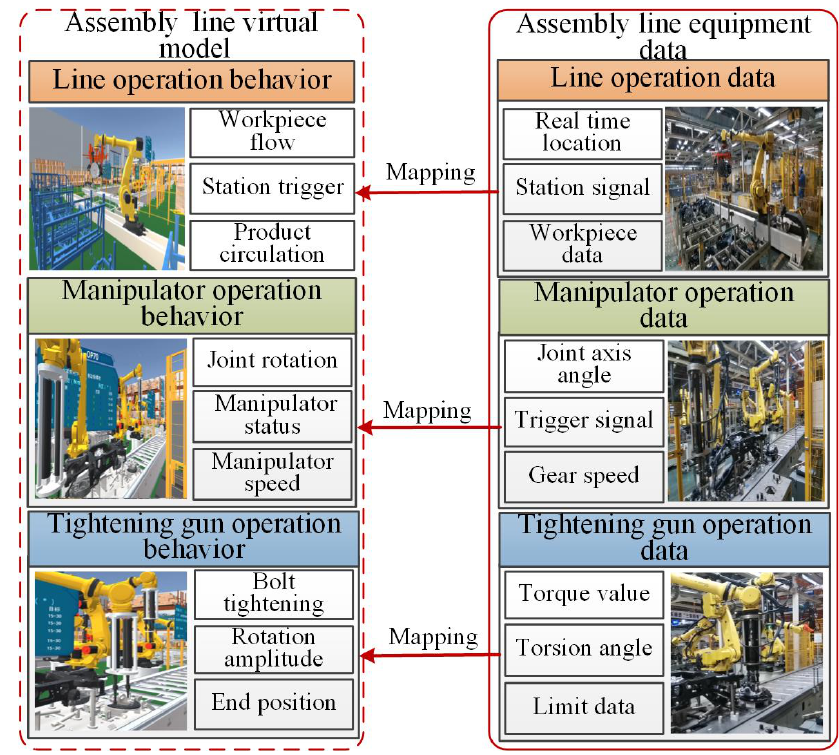
Figure 2. Mapping relationship between data and twin